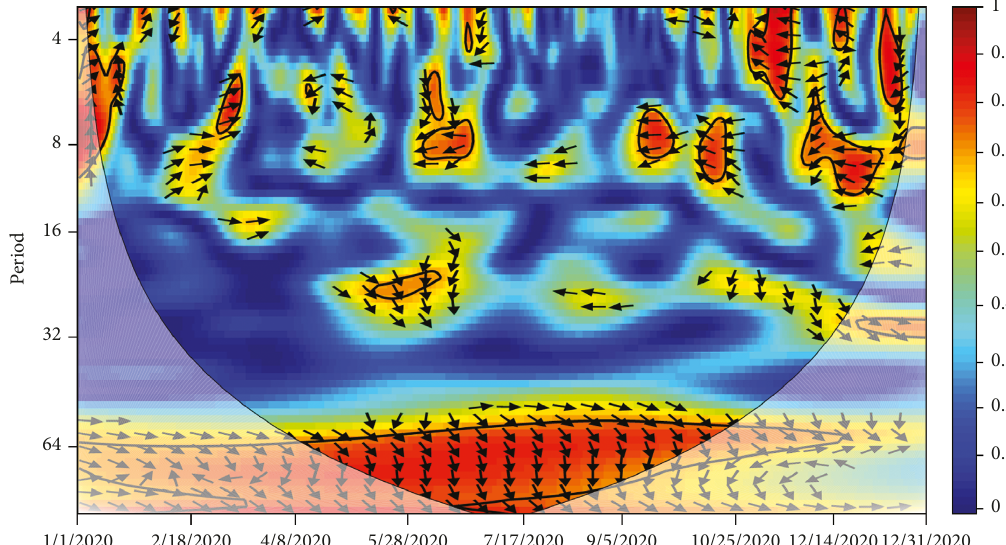
Figure 1: Wavelet coherency between illiquidity and EPU (tranquil period). Note: this figure reports the wavelet coherency between illiquidity and EPU during tranquil period. The black contour represents the regions in which the spectrum is significant at the 5% level against red noise. The cone of influence denoted as COI is designated by the lighter shade which delineates the high power regions. Time and scale (days) are represented on the horizontal and vertical axes, respectively. Arrows pointed to the right (resp. left) signify that the variables are in phase (out of phase). If arrows move to the right and up (resp. down), the first variable is the driver (resp. follower). By contrast, if arrows move to the left and up (down), the second variable is leading (resp.